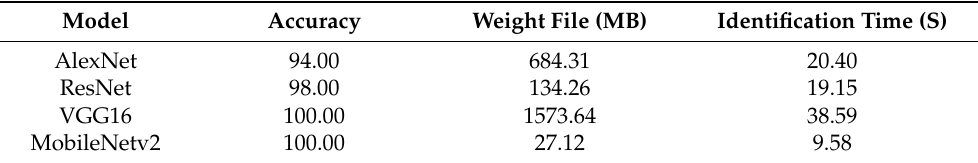
Table 10. Identification results of vehicle speed for different